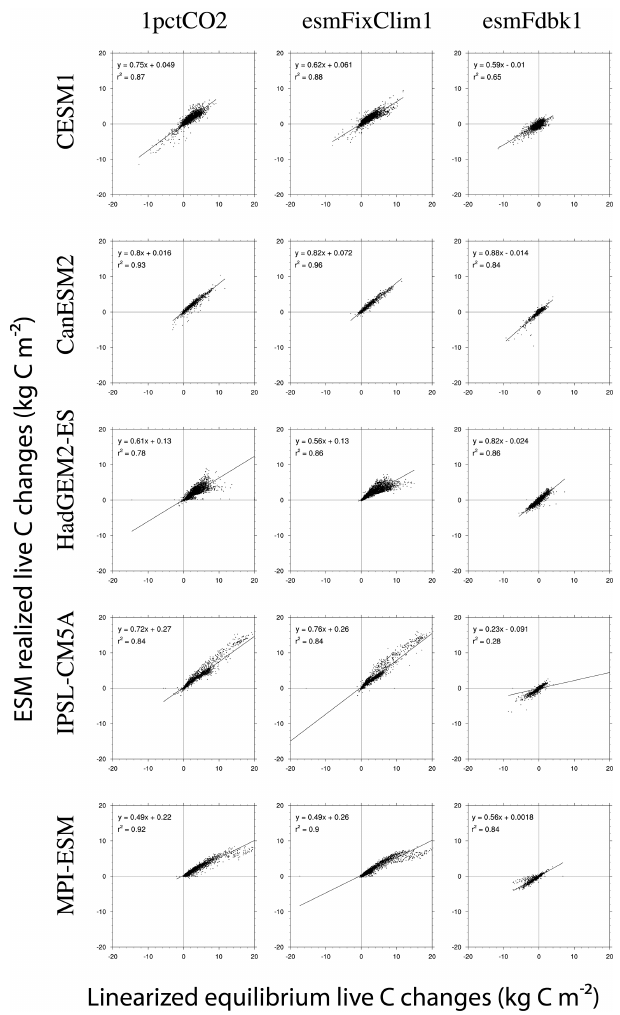
Figure 2. Scatterplots of linearized equilibrium live carbon pool changes (Eq. 13) versus actual ESM-predicted realized live carbon changes for each model and scenario.